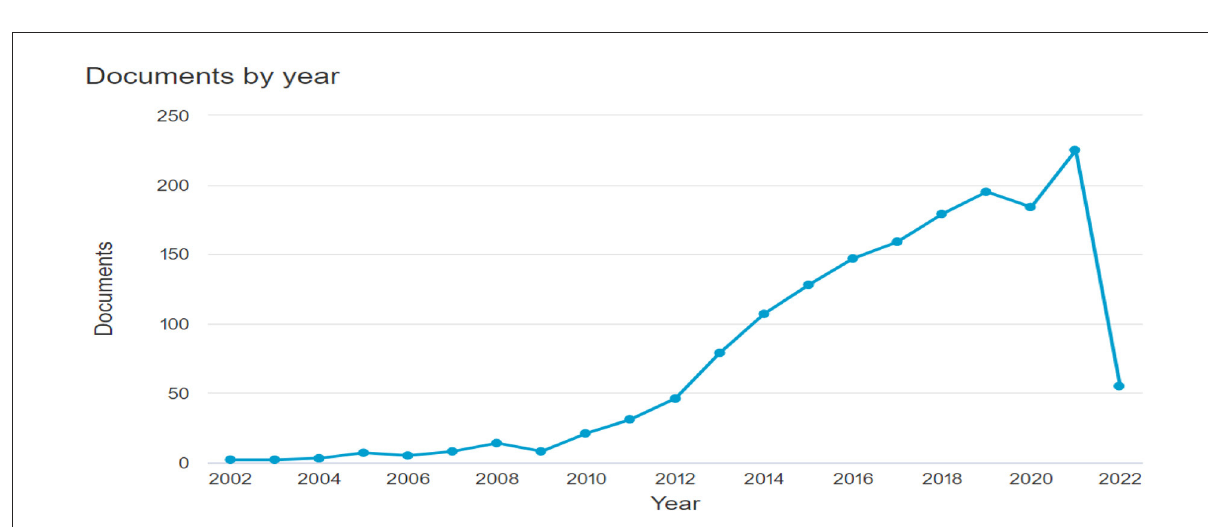
possible areas for the development of the research and its difficulty. For this, there is the bibliometric review, a quantitative analysis technique that uses mathematical and